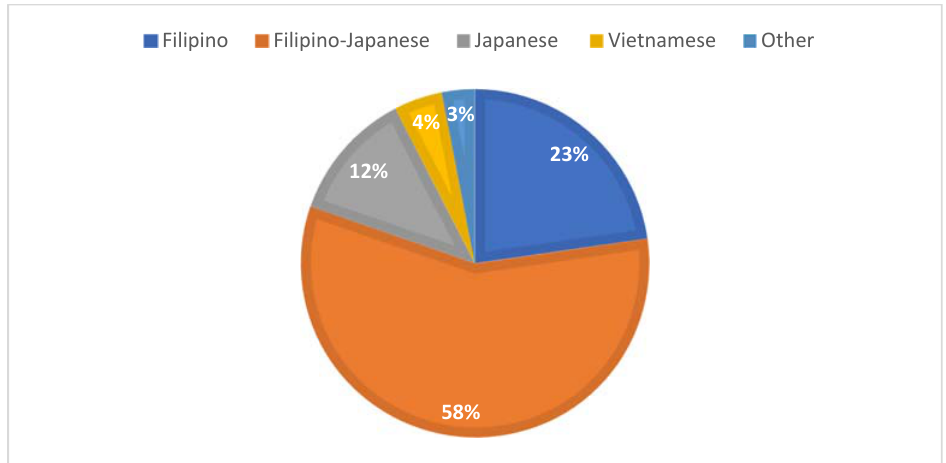
Figure 2. Biannual church camp ethnic composition September 2011–March 2019 (n = 66).